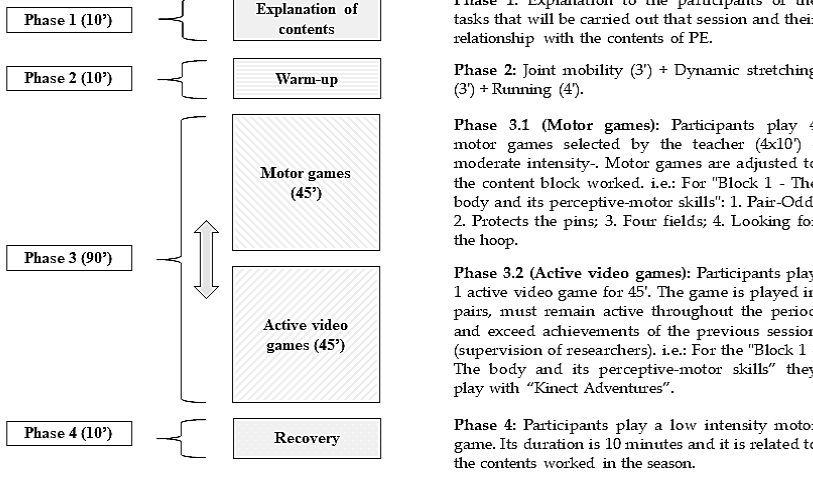
Figure 1. Explanation of a session of the intervention Figure 1 . Explanation of a session of the intervention program.